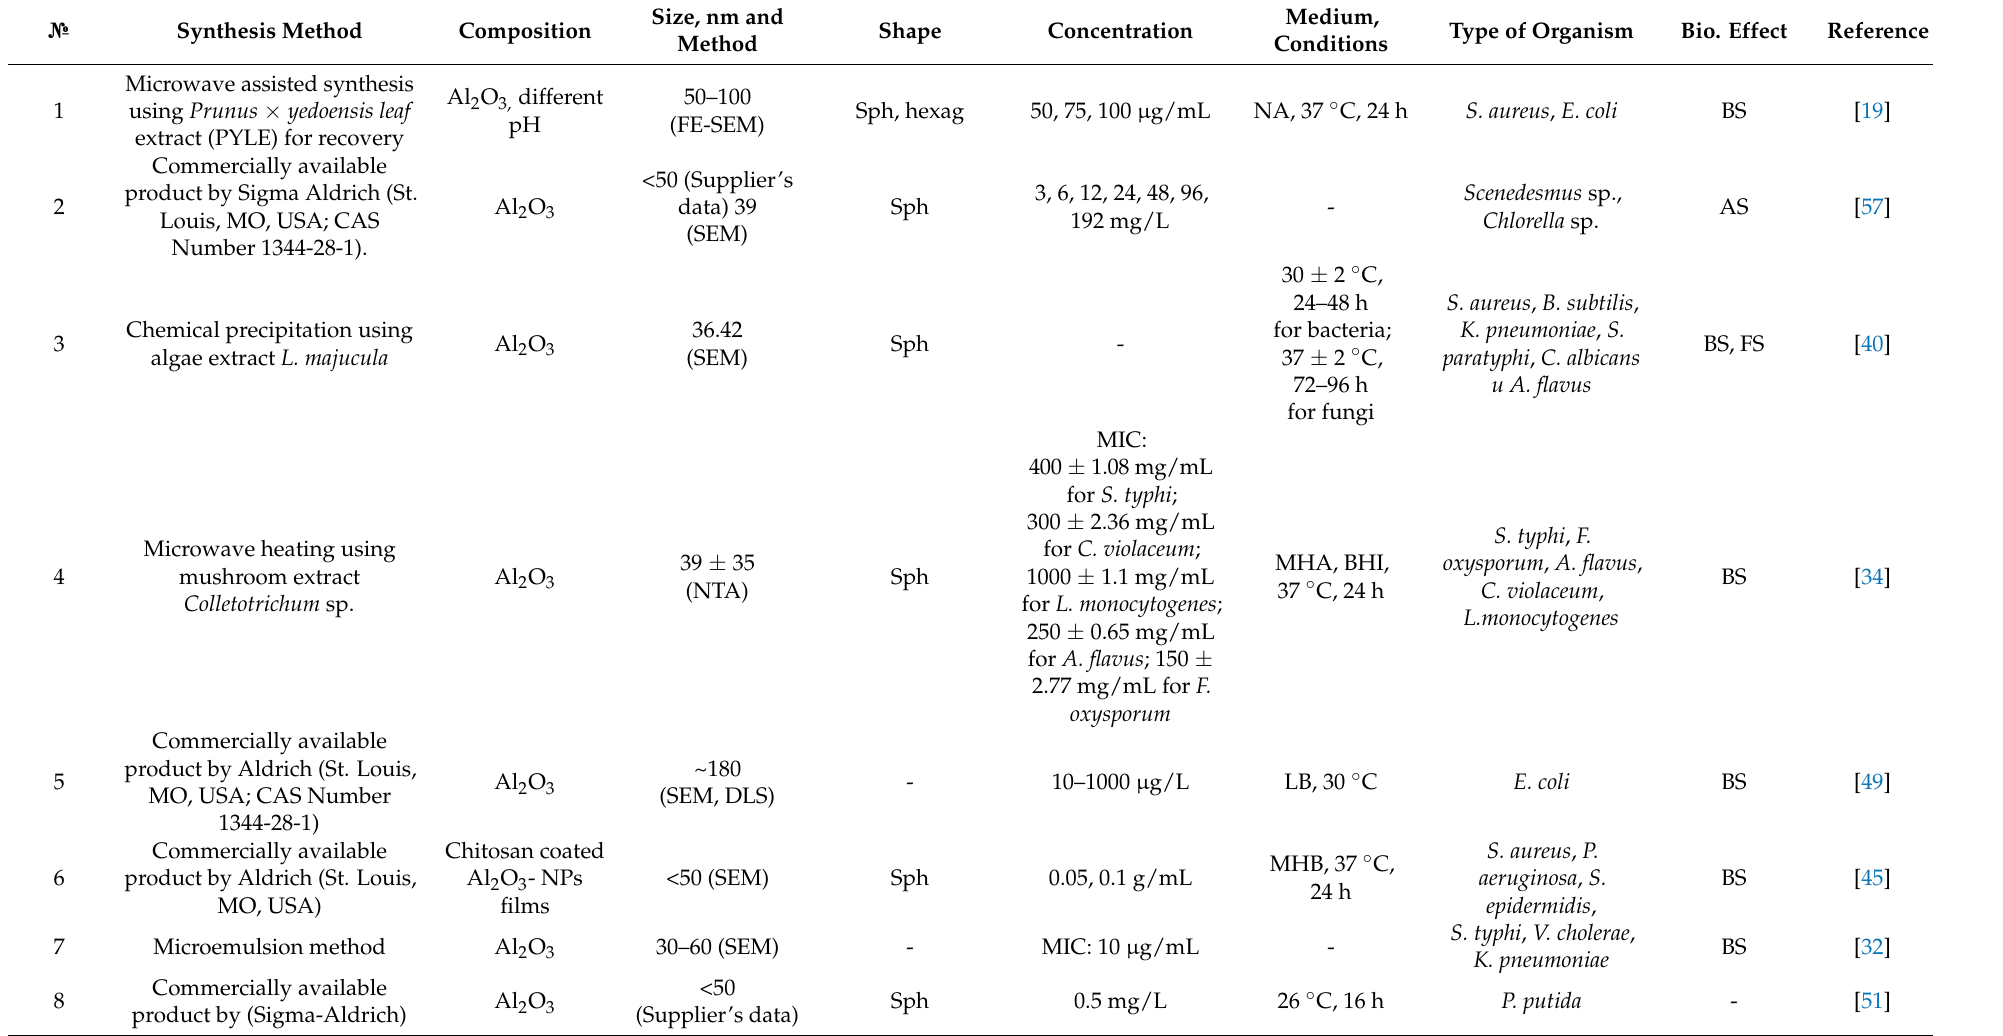
Table 1. Results of the action of aluminum oxide nanoparticles on the microbial growth reported in the